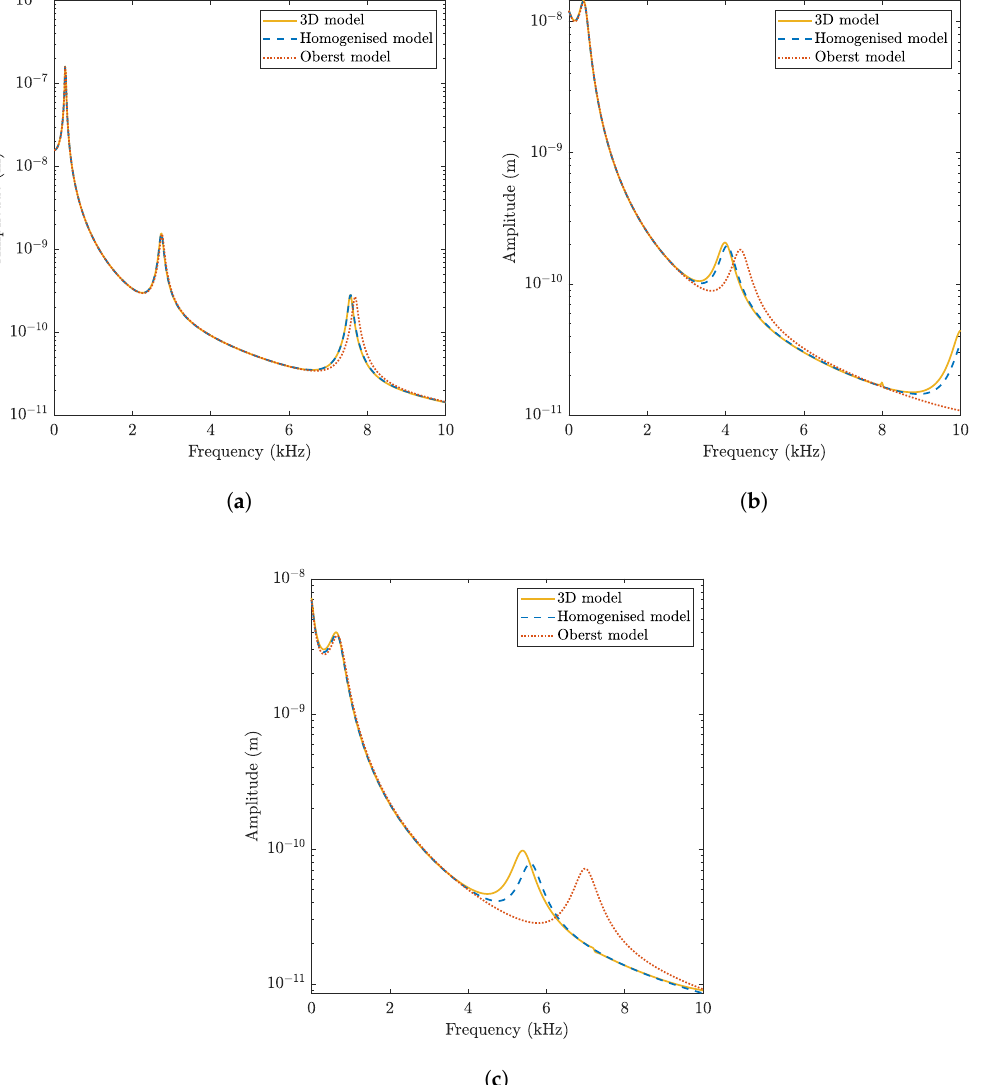
Figure 4. Amplitude of the transverse displacement of the simply supported FLD beam when subjected to a unit pressure: ( a ) H 2 = 2 mm; ( b ) H 2 = 6 mm; ( c ) H 2 = 10